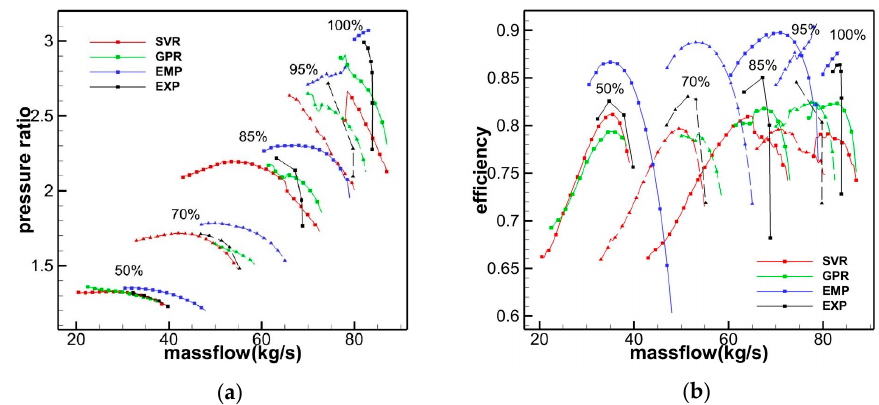
Figure 14. Comparison of experimental data and predicted performance by different models: ( a ) Total pressure ratio ; ( b ) Adiabatic efficiency.